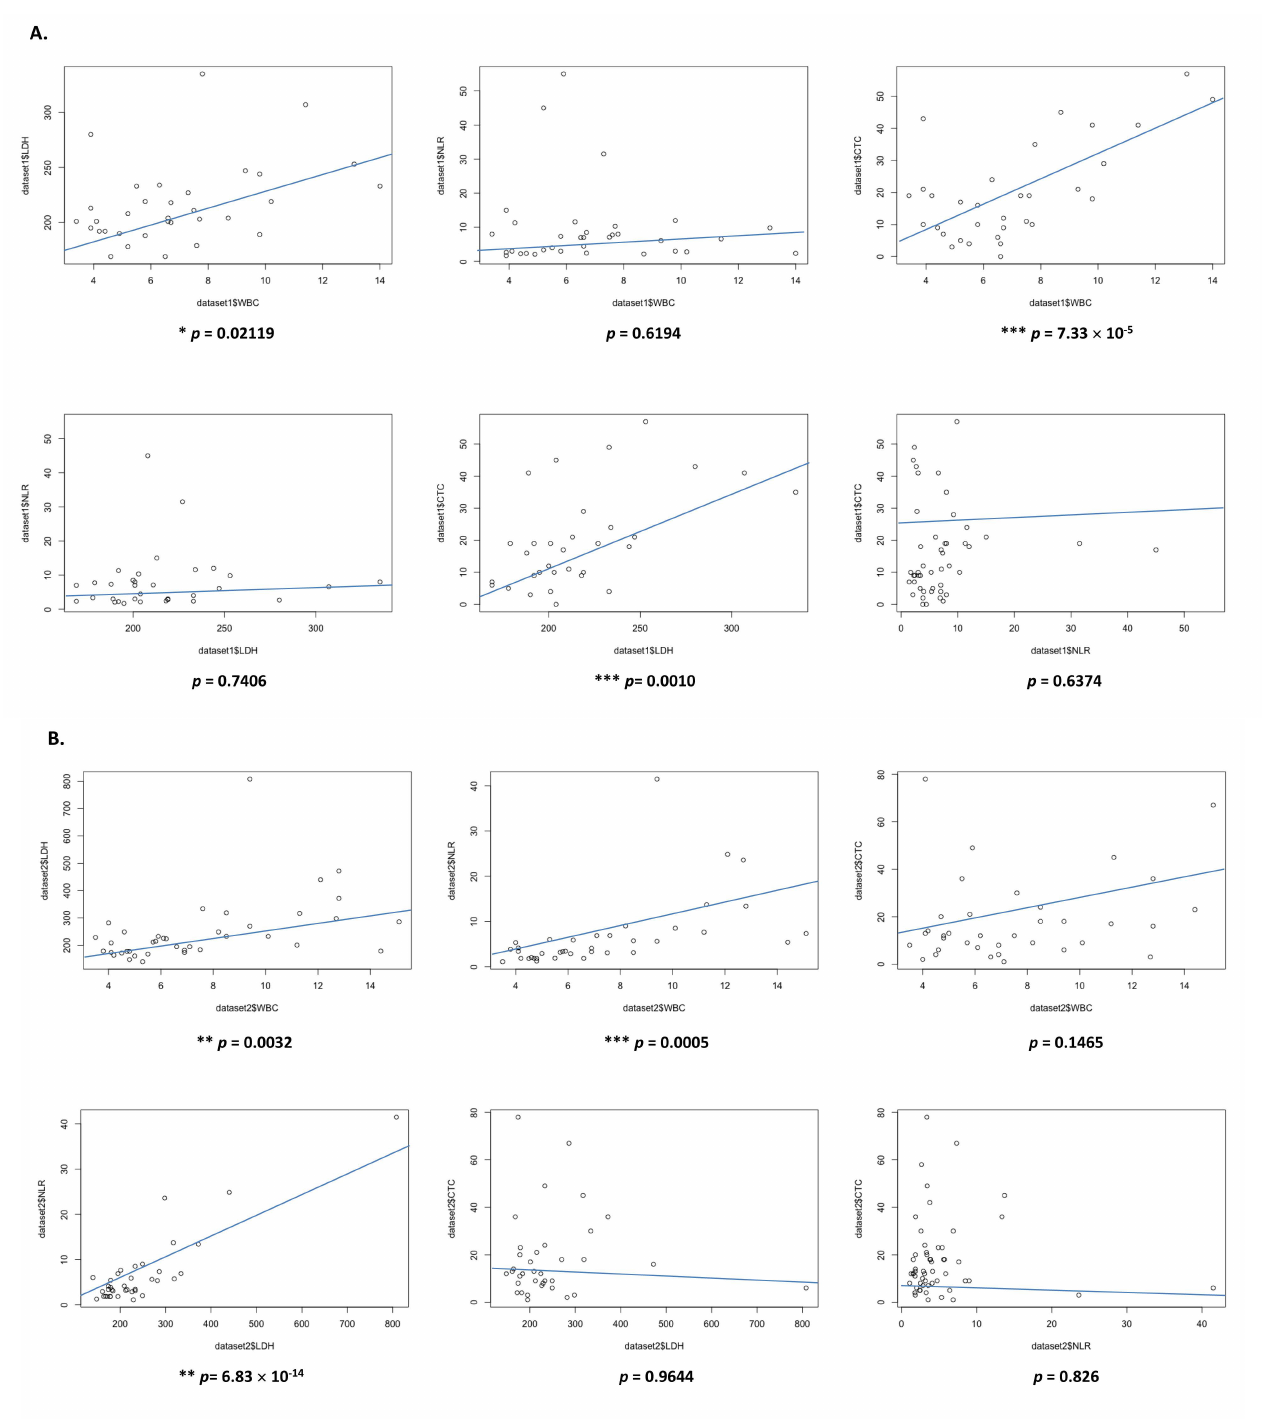
Figure 6. Correlations between systemic inflammatory markers and CTCs. At baseline, correlations between peripheral blood inflammatory markers (WBCs, LDH, NLR, dNLR, CTCs) were examined in cohort 1 ( A ) and cohort 2 ( B ). Scatter plots and Pearson’s correlation coefficients show correlations between continuous blood biomarkers (* p < 0.05, ** p < 0.01, *** p <